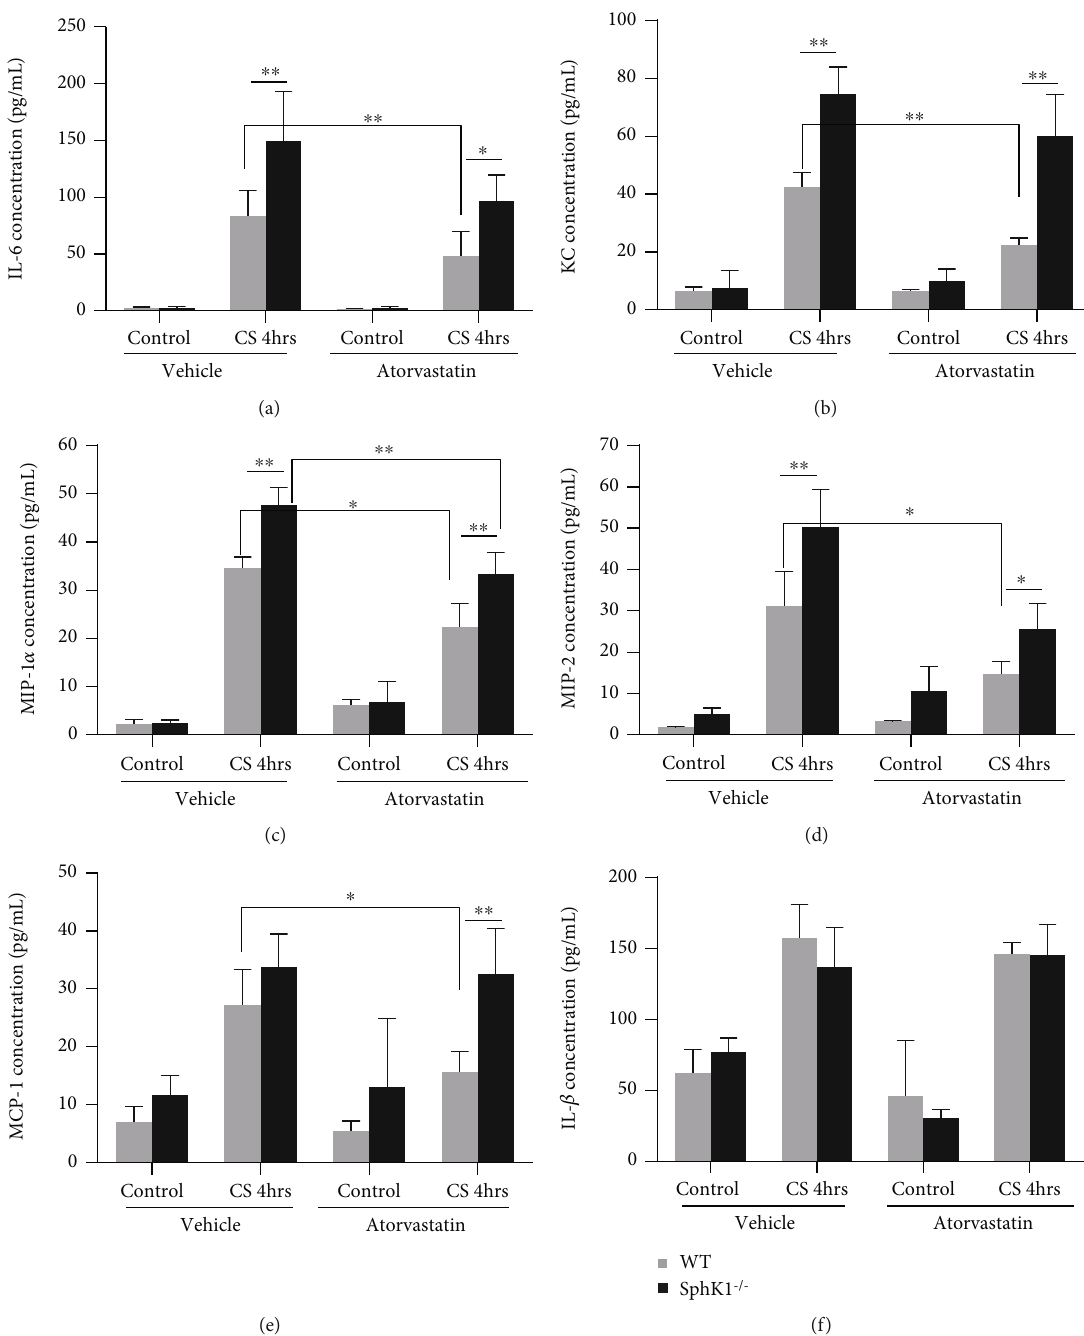
Figure 4: Atorvastatin attenuated cyclic stretch- (CS-) mediated cytokine generation from mouse-isolated endothelial cells, but SphK1 knockout reversed this e ff ect. The isolated ECs were seeded on Flexcell plate and cyclic stretched (CS) (18% elongation, 0.5Hz, 4 hours). After cyclic stretch, the medium was harvested for ELISA. CS signi fi cantly increased cytokine release in the WT endothelial medium. These cytokines include IL6, KC, MIP-1 α , MIP-2, and MCP-1, but not IL-1 β . The CS-mediated cytokine release in WT mouse endothelial medium was signi fi cantly attenuated by pretreatment of atorvastatin; CS-mediated cytokine concentrations were signi fi cantly higher in SphK1 -/- mouse endothelial medium than those in WT mice. Moreover, SphK1 knockout reversed the inhibitory e ff ect of atorvastatin in cytokine generation in endothelial cells. ( ∗ P < 0 : 05 , ∗∗ P < 0 : 01 SphK1 -/- Atorva/HT, 52 : 13 ± 23 : 47 vs. 28 : 95 ± 13 : 38 pg/ml , HT, 65 : 48 ± 20 : 81 vs. 60 : 17 ± 13 : 41 pg/ml , P > 0 : 05 , n = 5 ), P > 0 : 05 , n = 5 ); MIP-2 (SphK1 -/- Vehicle/HT vs. SphK1 -/- Atorva/HT, 90 : 82 ± 37 : 36 vs. 65 : 64 ± 14 : 72 pg/ml , P > 0 : 05 , n = 5 ); MCP-1 (SphK1 -/- Vehicle/HT vs. SphK1 -/- Atorva/